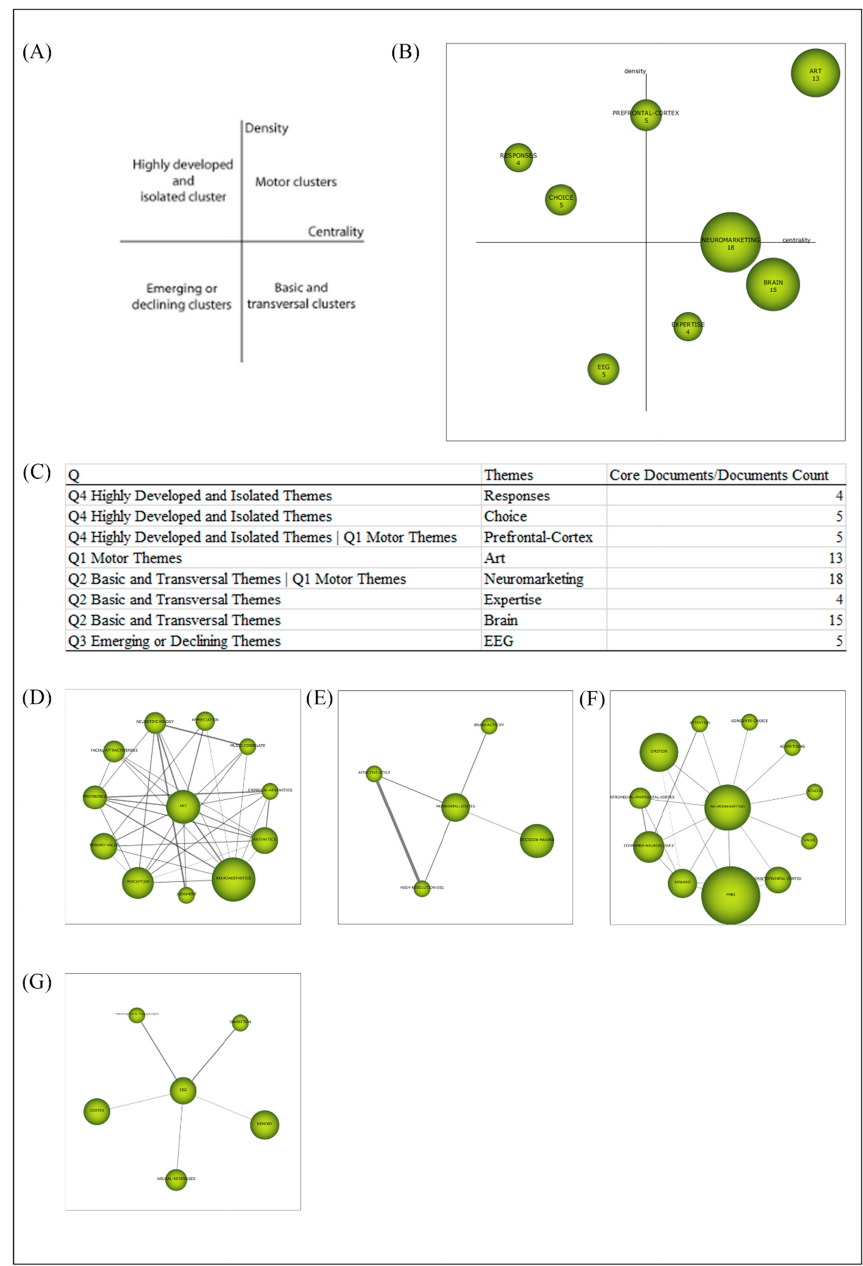
Figure 8. ( A ) Callon’s density and centrality measures. ( B ) SciMAT Strategic Diagram (2010–2019). ( C ) Quadrants/Themes/CoreDocuments-Documents Count. ( D ) ART cluster, ( E ) PREFRONTAL CORTEX cluster, ( F ) NEUROMARKETING cluster, and ( G ) EEG